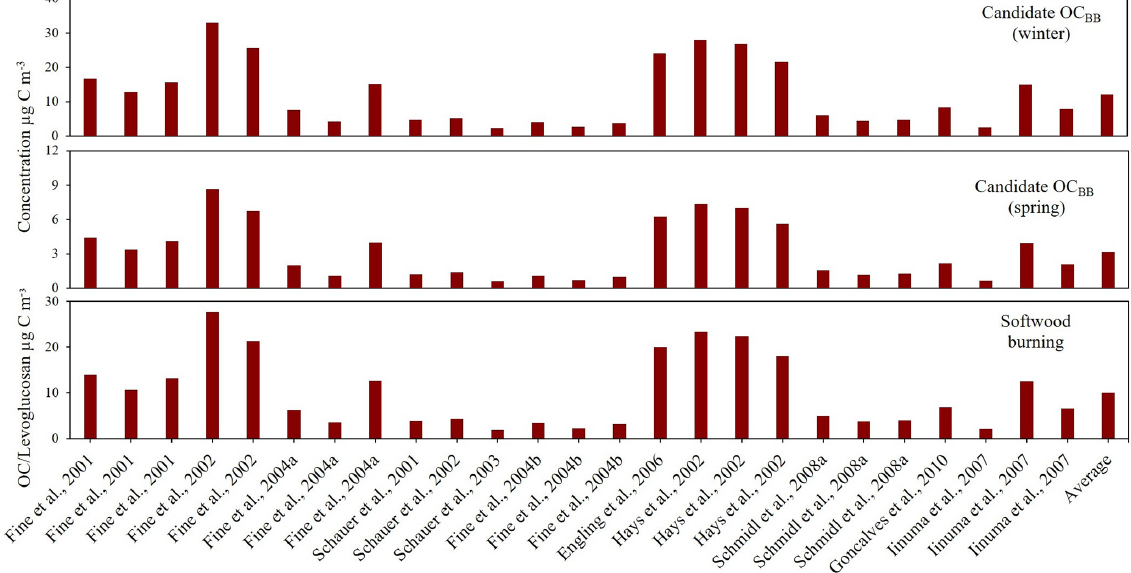
Figure 11. Comparison of previously reported OC / levoglucosan ratios for softwood burning.